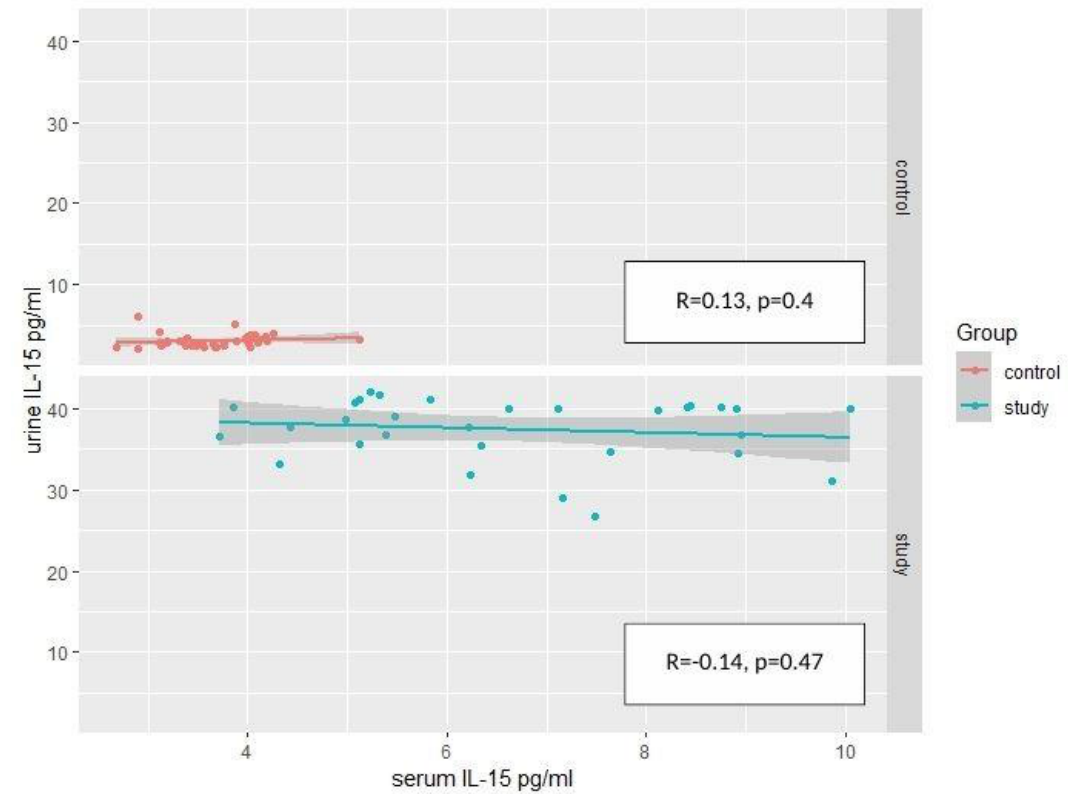
Figure 3. Correlations between the concentration of IL-15 in the serum and urine, considering the division into the study group and the control group (R-Pearson’s correlation coefficient). The test probability of both correlations is higher than the adopted significance level α = 0.05).